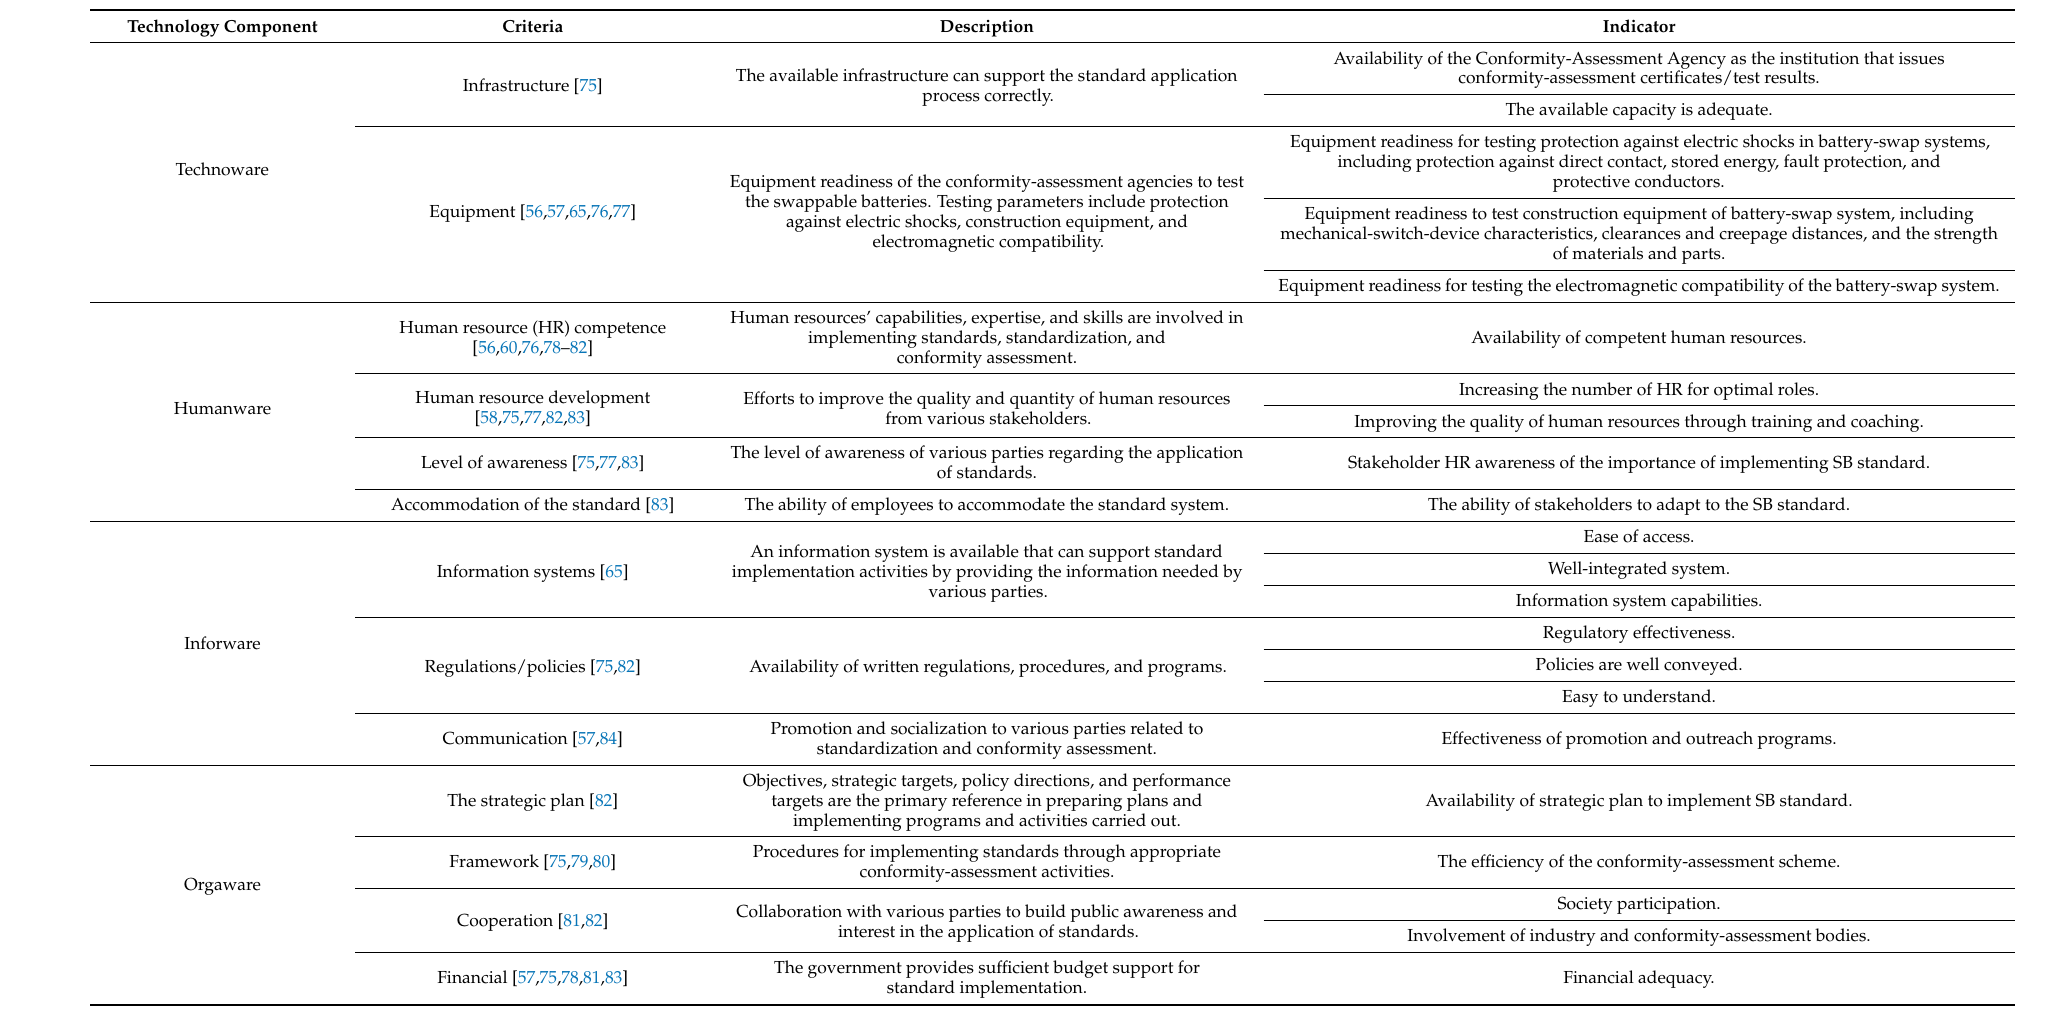
Table 1. Operationalization of technology readiness measurement